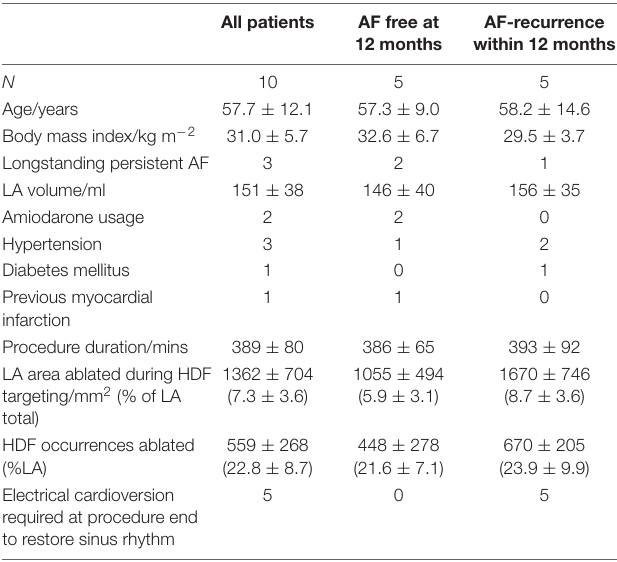
TABLE 1 | Clinical and procedural characteristics of patients with and AF recurrence within 12 months following ablation. All